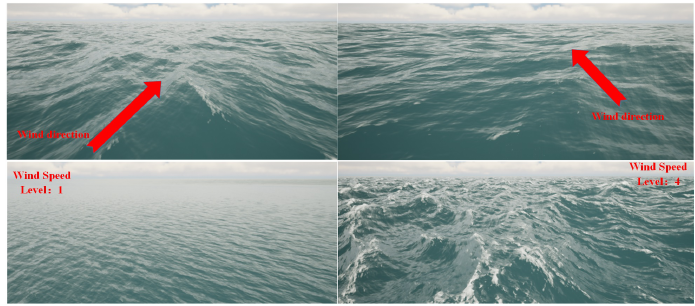
Figure 13. Sea effect due to the wind speed and direction.